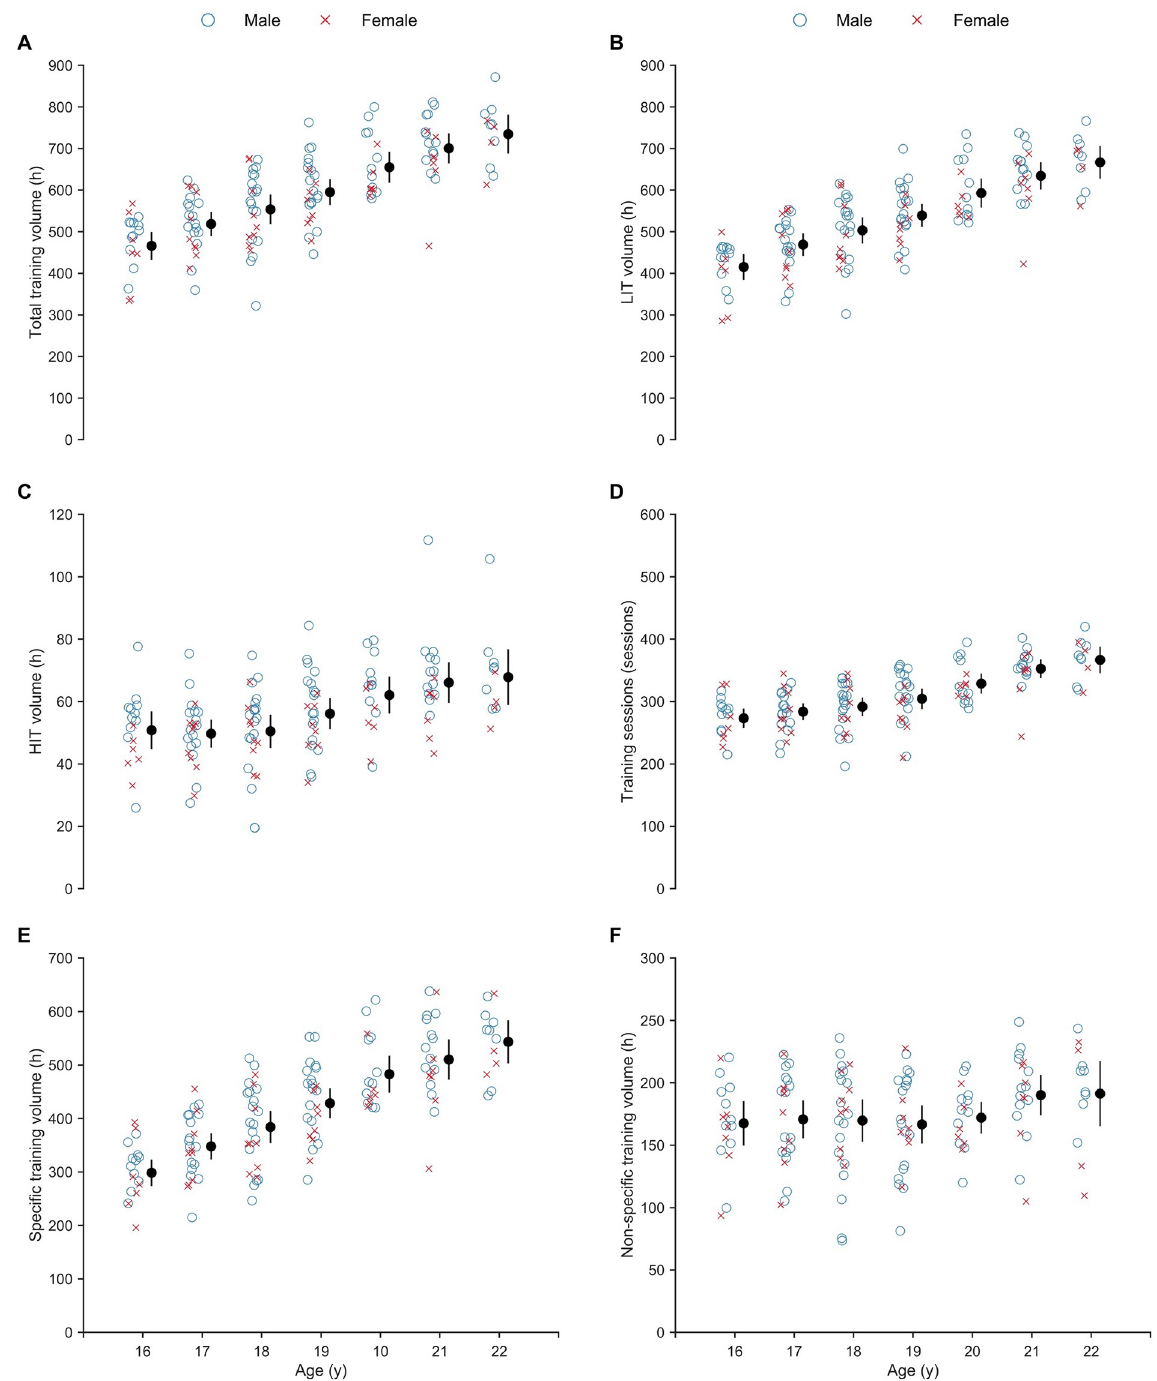
Fig 2. Progression in annual endurance training from age 16 to 22 years (y) old. (A) total annual training volume; (B) low-intensity training (LIT) volume; (C) high-intensity training (HIT) volume; (D) number of endurance training sessions; (E) specific (i.e., on-snow skiing and roller skiing) training volume; and (F) non-specific (i.e., running, cycling, orienteering, ski-walking and “other”) training volume. Closed circles and whiskers: mean ± 95% CI.